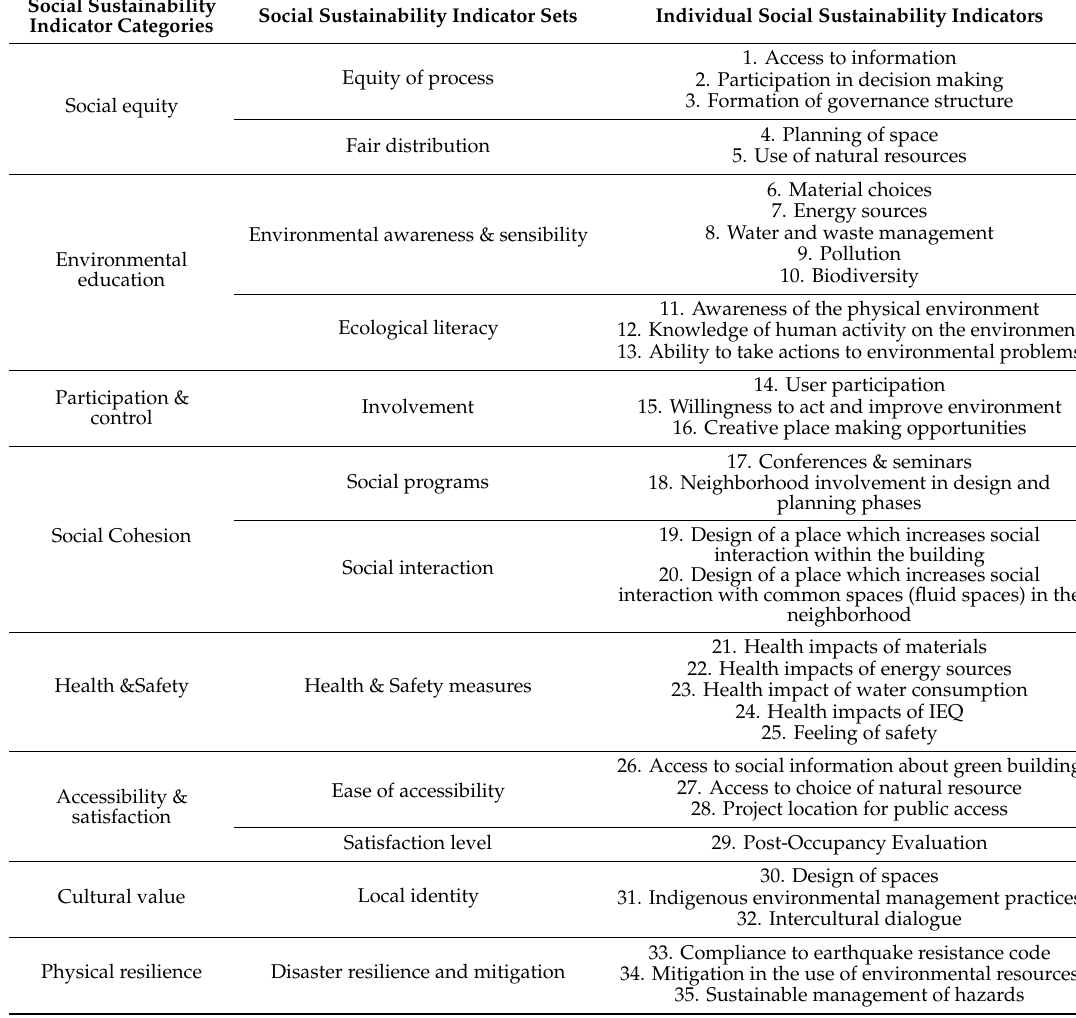
Table 1. The final set of 8 social categories and 35 indicators for social sustainable developed [51,63]. Social Sustainability Indicator